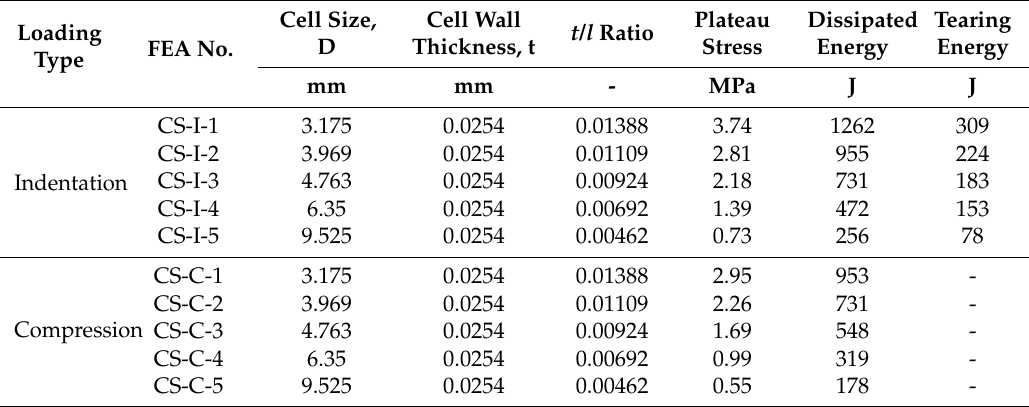
Table 5. FEA results of honeycombs with constant cell wall thickness and different cell